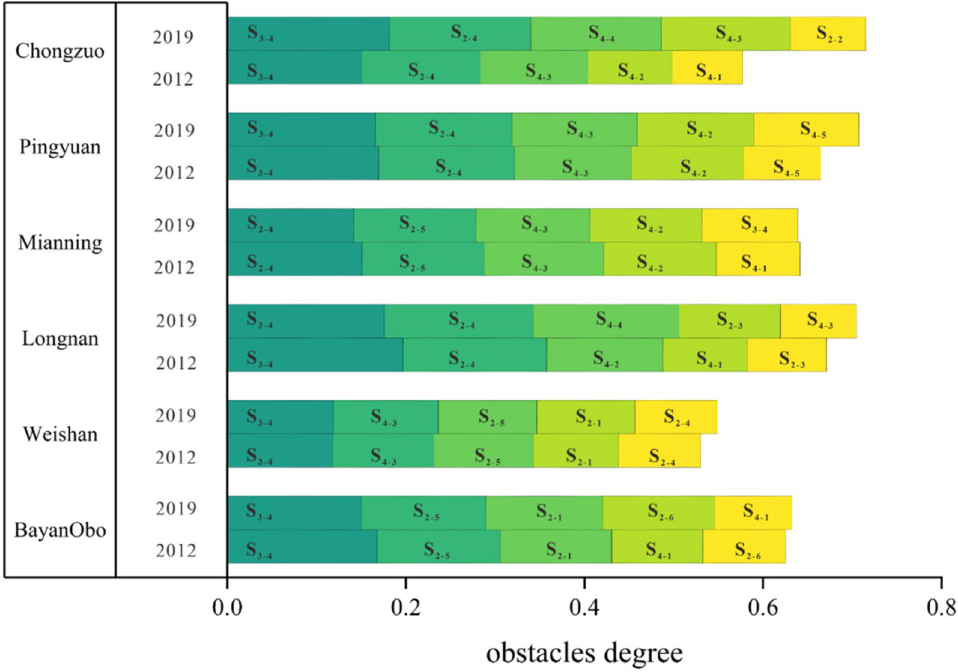
Figure 6. Top 5 obstacle indicators for the support index of the